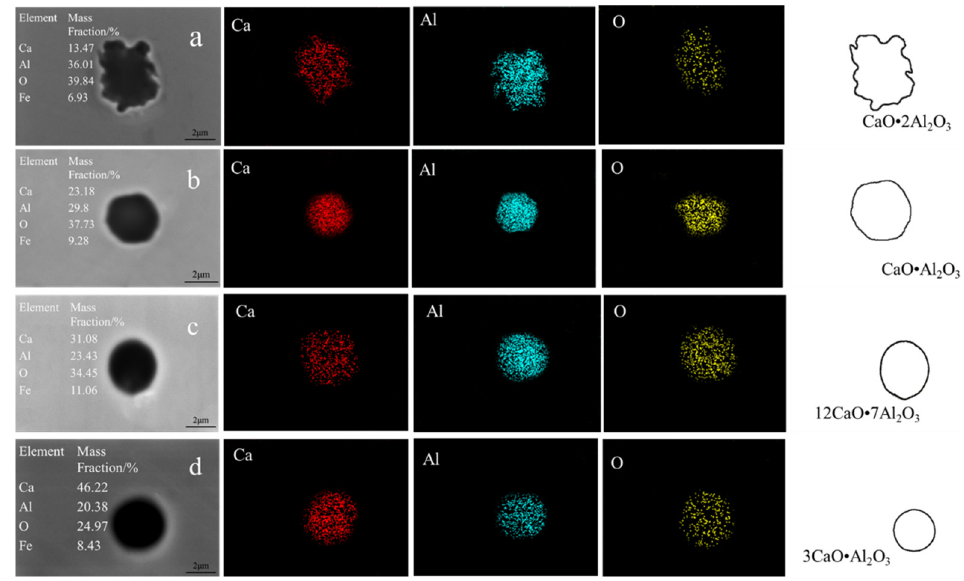
Figure 4. Elemental mappings of different types of inclusions detected after calcium additions in